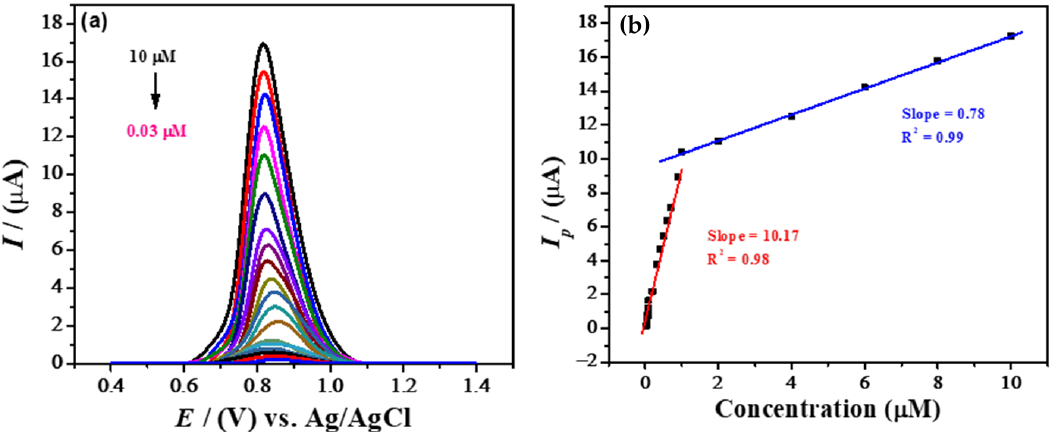
Figure 5. ( a ) Square wave voltammograms of various concentrations of NBS ranging from 0.03 μM to 10 μM under pre-optimized conditions. ( b ) The calibration plot of NBS concentrations ranging from 0.03 μM to 10 μM under optimized conditions with three distinct regions.